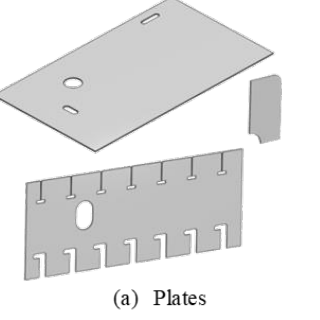
Figure 7. Examples of mirroring type part.